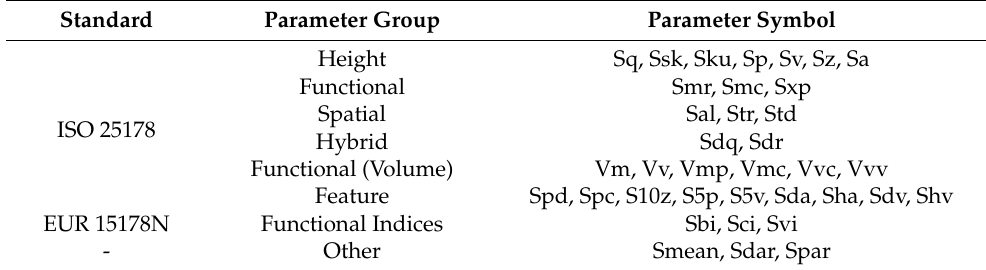
Table 4. List of standard and non-standard areal parameters used to characterize measured surfaces. Standard Parameter